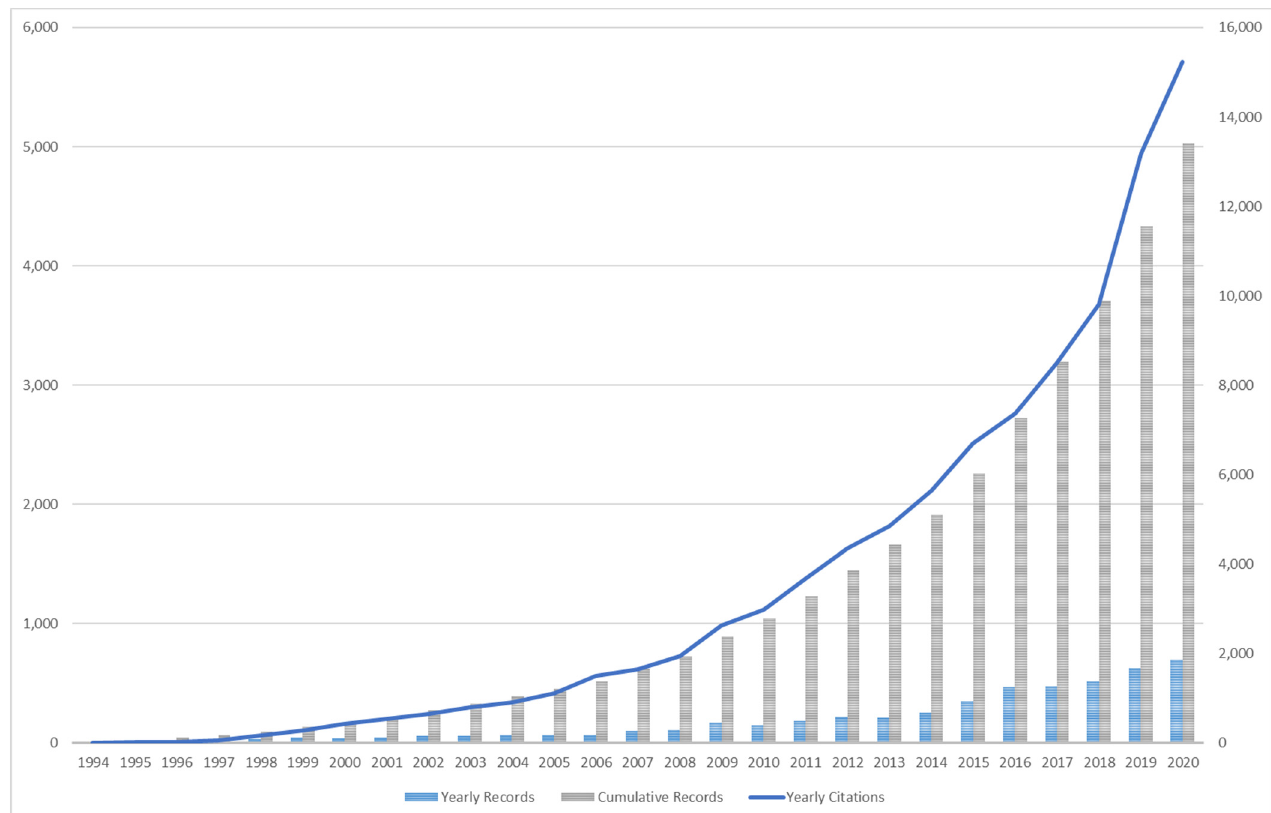
Figure 2. Yearly records, cumulative records, and yearly citations for “social cohesion.” The left vertical axis represents the number of records; the right vertical axis represents the number of citations.